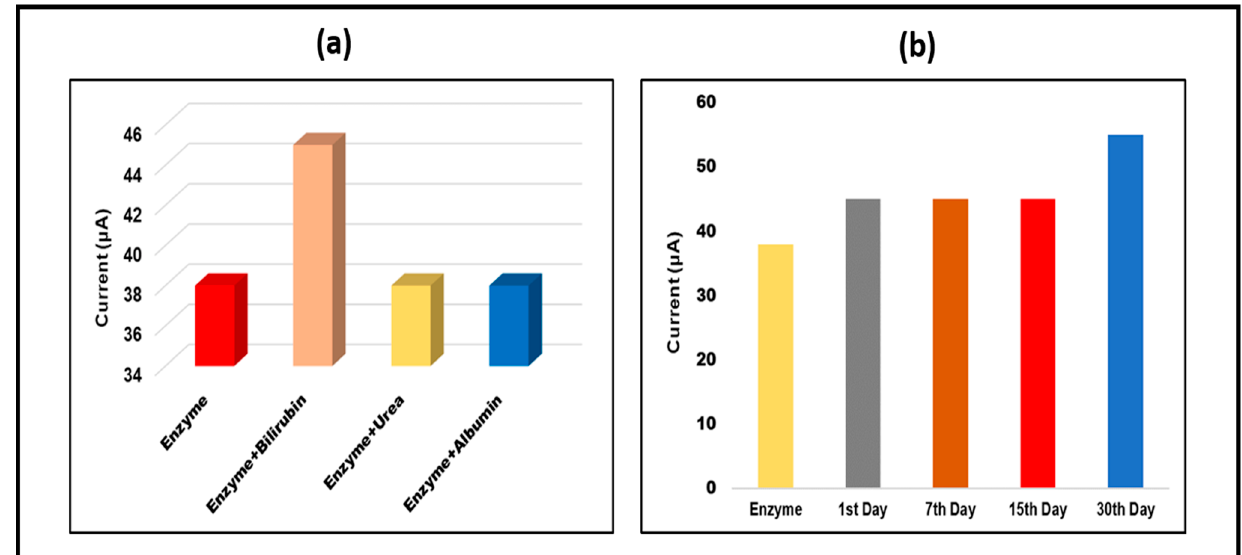
Figure 8. ( a ) Analysis of peak current CV-value of Bilirubin/Enzyme/Ag-NPs/PBs binding with the interferent, Urea and Albumin. ( b ) The electrochemical test was utilized to assess the stability of the constructed paper-based sensor for Bilirubin on the 1st, 7th, 15th, and 30th day.